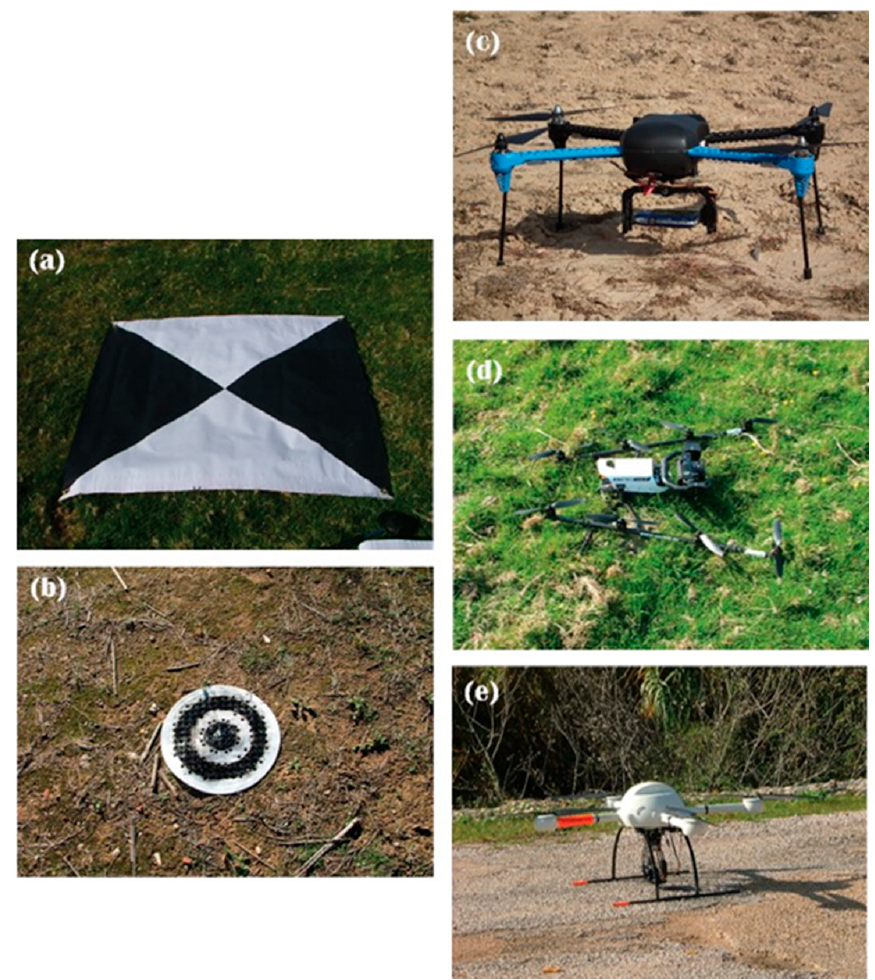
Figure 3. Types of Ground Control Points (GCPs) and Unmanned Aerial Vehicles (UAVs) used to collect the imagery at each reach. ( a ) 1 m × 1 m Squared GCP used in the Central-Baltic reach; ( b ) 0.30 m diameter GCP used in the Mediterranean and Very Large Rivers reaches; ( c ) IRIS9+ UAV